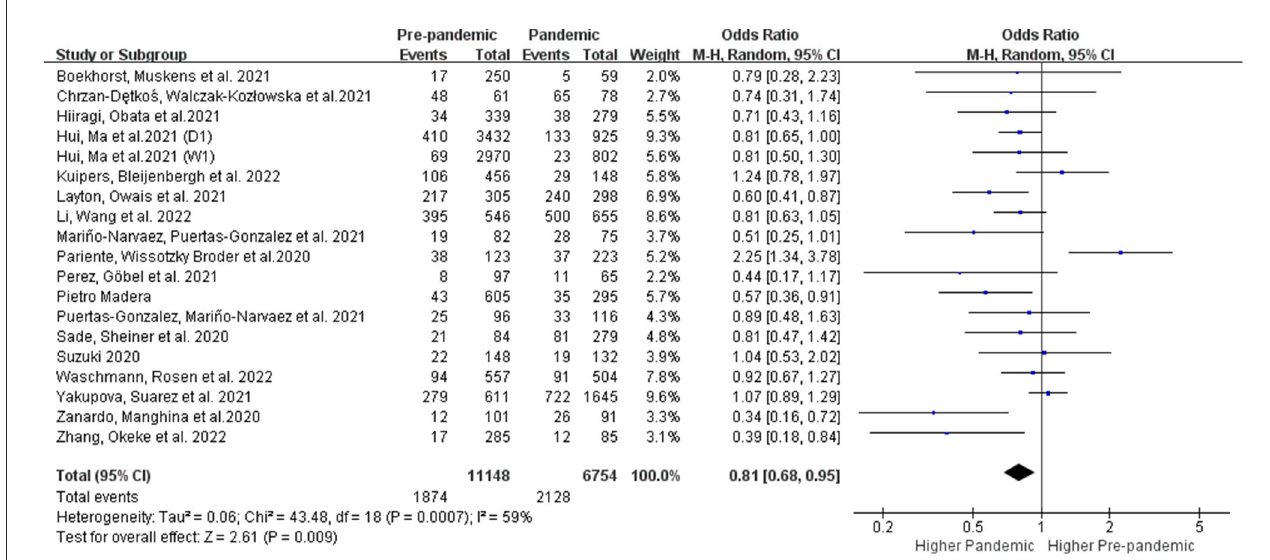
FIGURE2 Overall meta-analysis comparing the prevalence of PPDS before and during the COVID-19 pandemic.